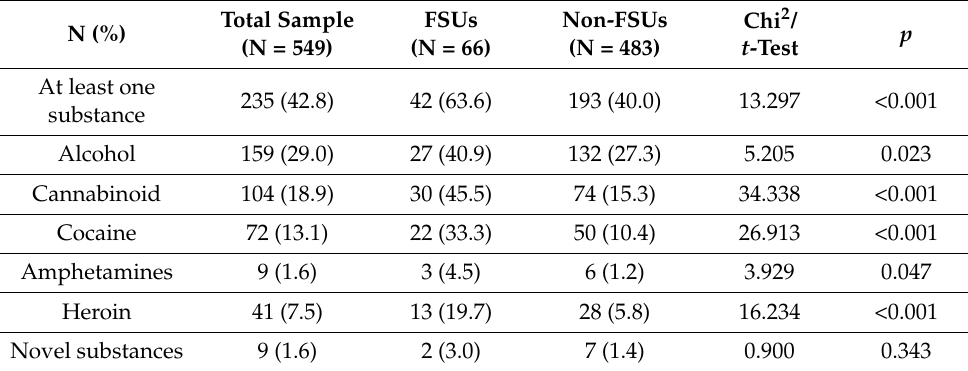
Table 3. Presence of illicit substances in the entire sample and in the frequent service users (FSUs) and non-FSUs subgroups.